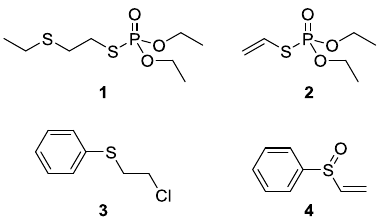
Figure 1. ( 1 ) Demeton- S ; ( 2 ) S -vinyl degradation product; ( 3 ) CEPS; and ( 4 ) vinyl phenyl sulfoxide.